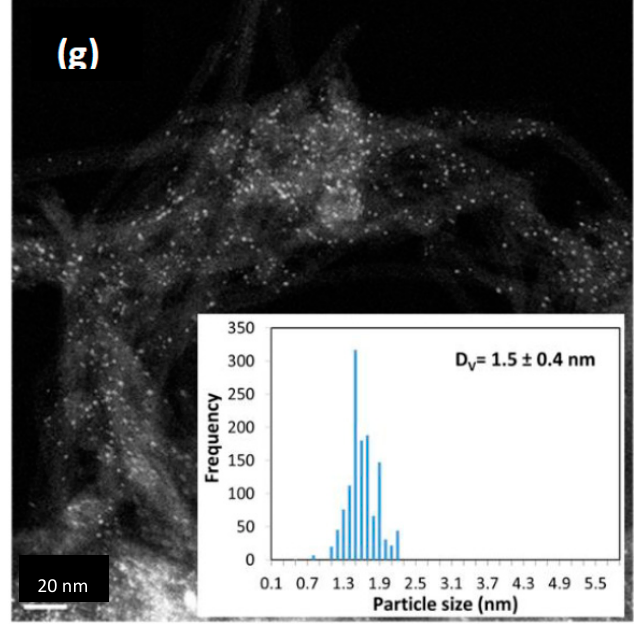
Figure 4. STEM images and particle size histograms for: ( a ) MWCNT I; ( b ) MWCNT I Oxd; ( c ) HB Nanofibers; ( d ) MWCNT II; ( e ) MWCNT II OH; ( f ) MWCNT II COOH using PHC; and ( g ) MWCNT II COOH using PTA.